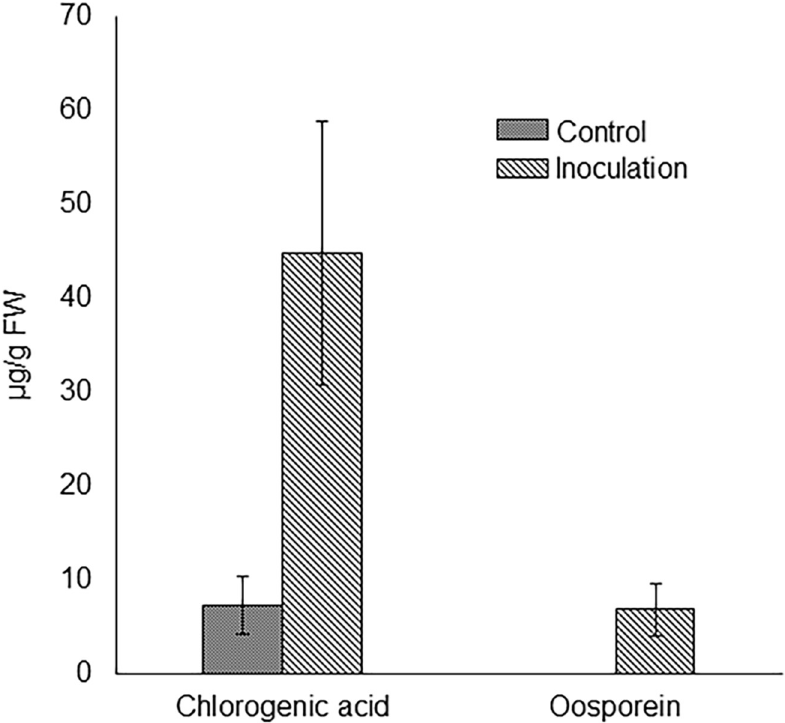
Fig 6. Concentrations of oosporein and chlorogenic acid in the inoculation test. Differences between treatments were evaluated using Student’s t -test. The results are expressed as means ± SE (n = 5). The concentration of chlorogenic acid was slightly higher in the roots inoculated with C . cupreum compared with that in the control roots ( P = 0.051).